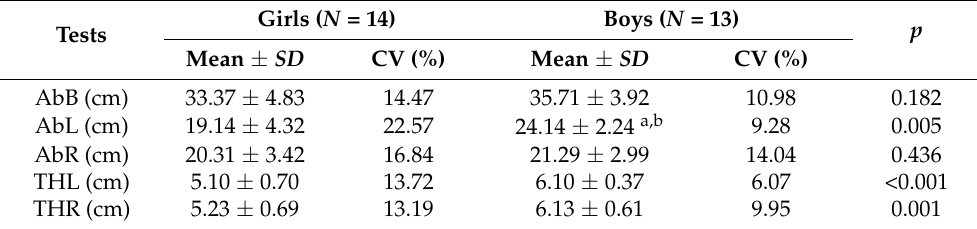
Table 2. Performance variables.